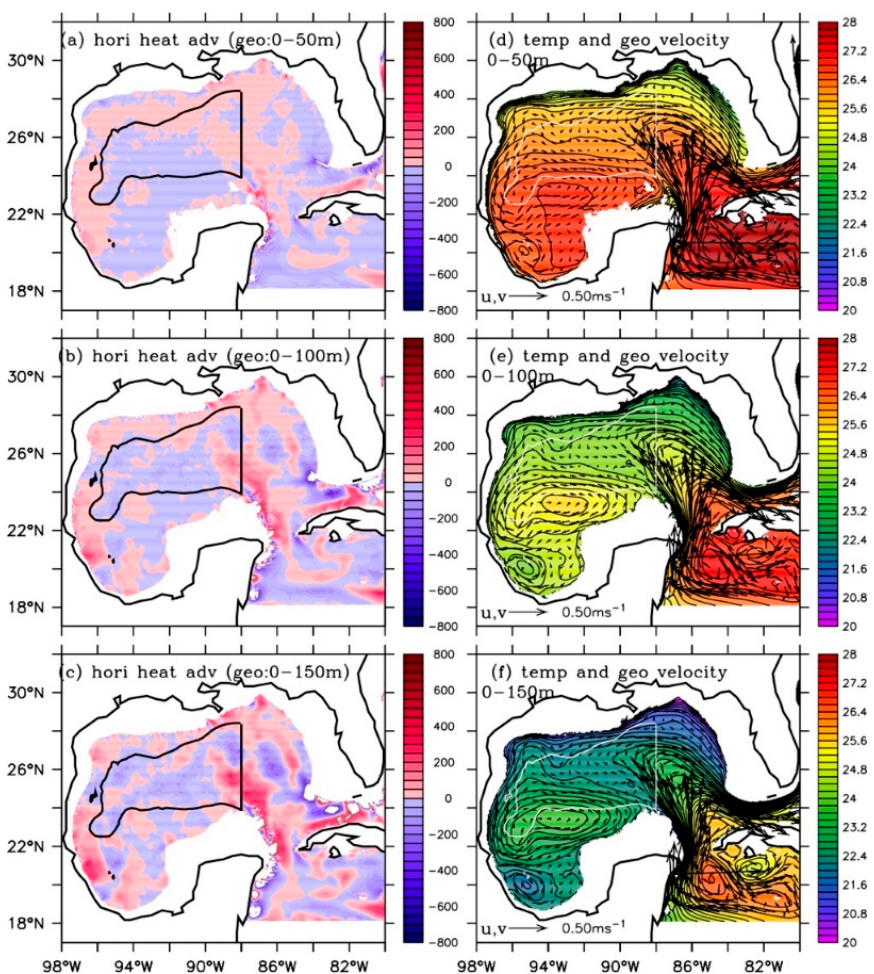
Figure 5. Mean horizontal heat advection caused by geostrophic current, arranged as in Figure 4.